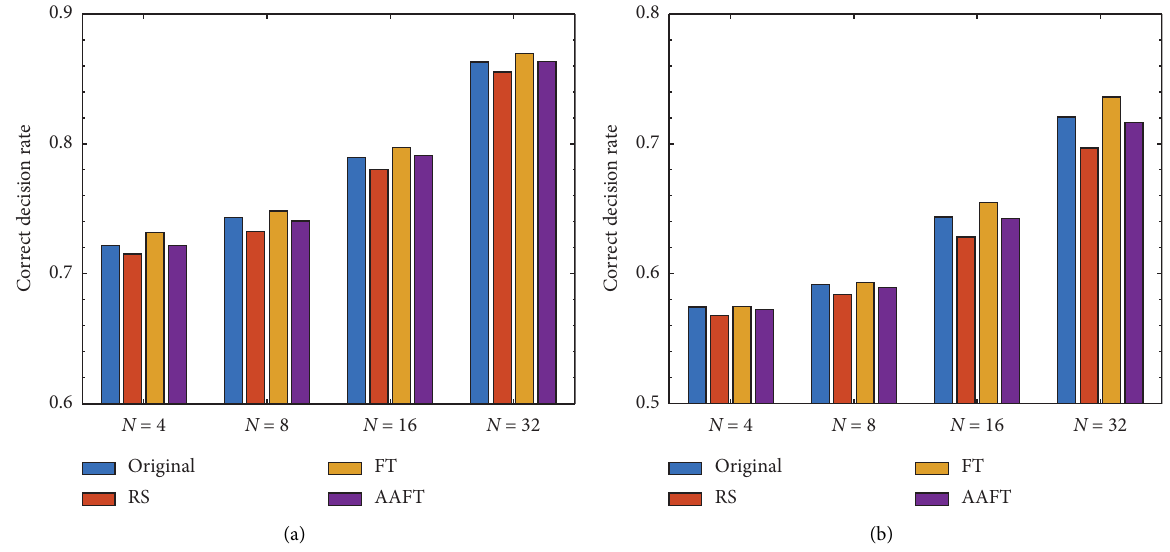
Figure 6: CDR of the laser chaos time series and its surrogates at a time cycle of 1,000 for (a) P